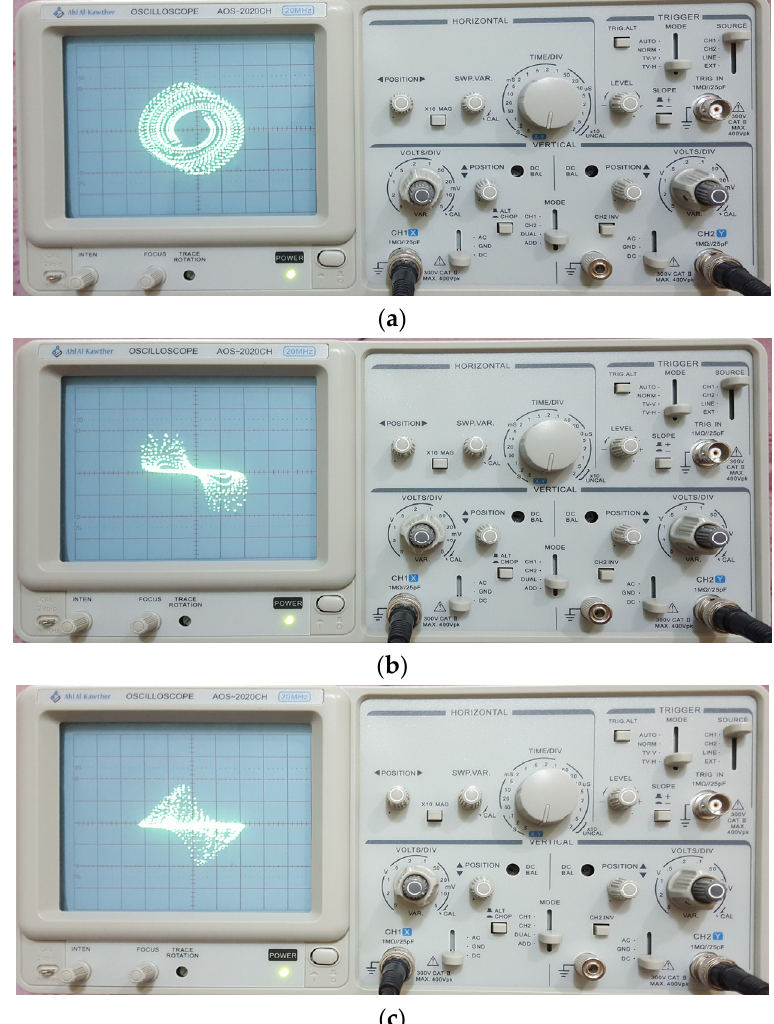
Figure 15. The phase portraits of chaotic attractors of the proposed fractional-order memristive chaotic system obtained from the microcontroller implementation: ( a ) x–y ; ( b ) y–z ; ( c ) x–z .